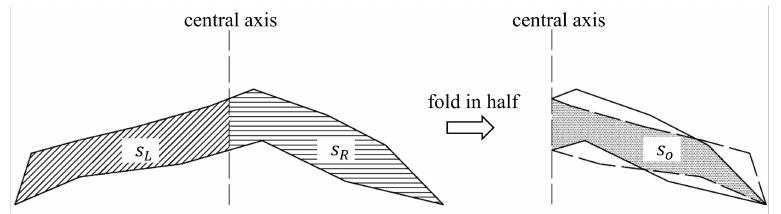
Figure 2. Principle of symmetry rate.